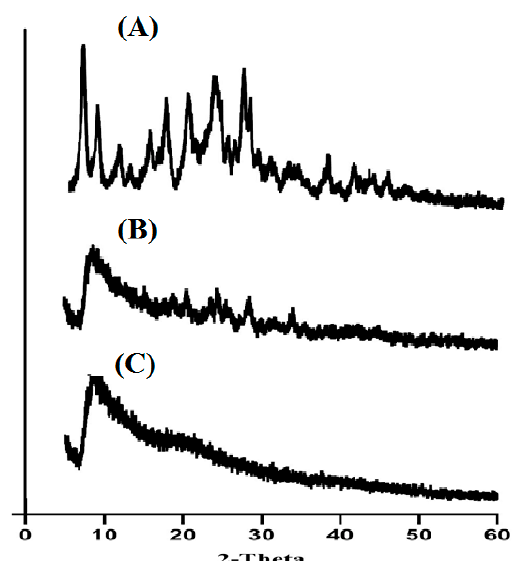
Figure 5. XRD of ( A ) DS, ( B ) unloaded Car934-g-poly(acrylic acid) hydrogel and ( C ) loaded Car934-g-poly(acrylic acid) hydrogel.